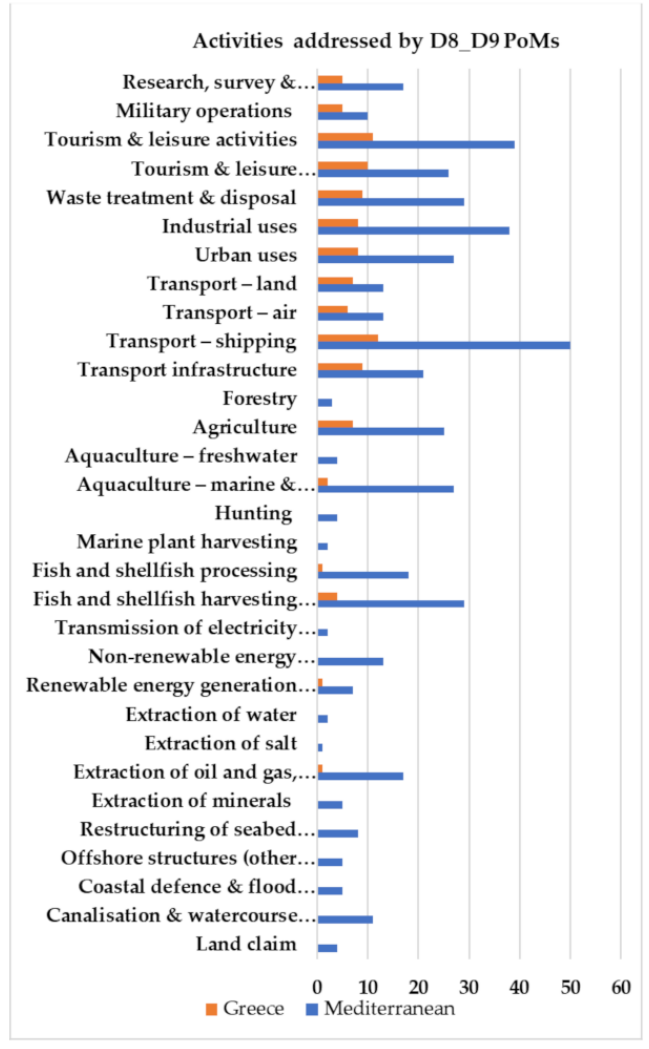
Figure 17. Measures addressing activities for Greece and Mediterranean MSs under Contaminants